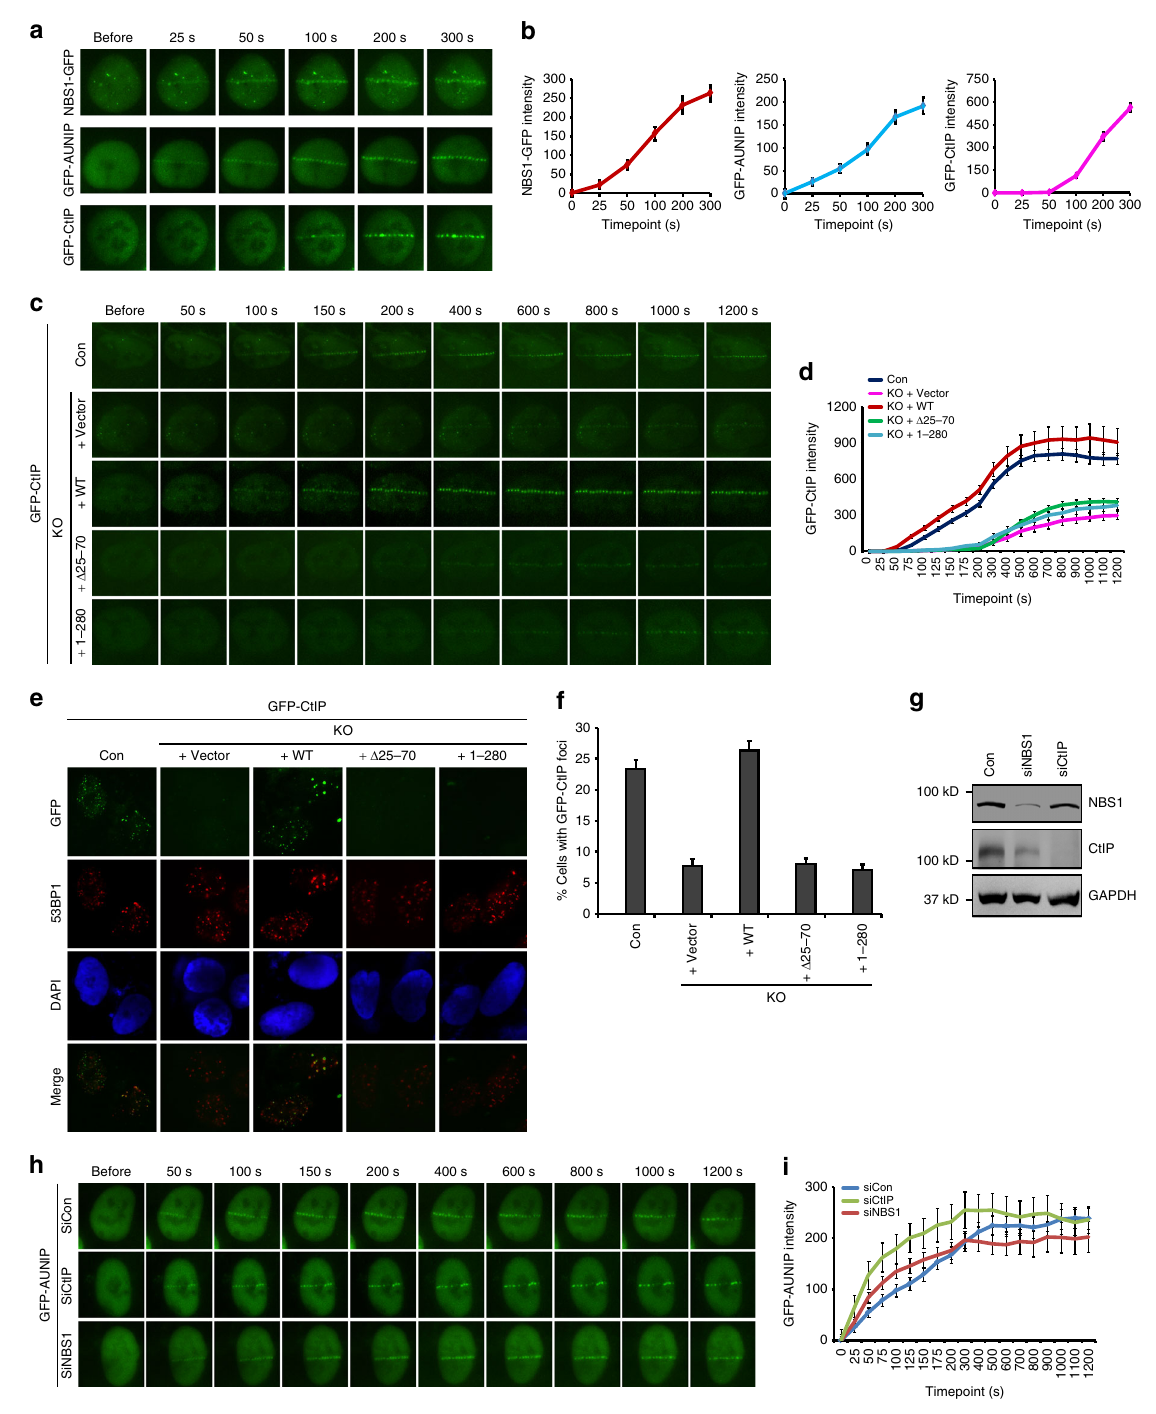
Fig. 5 AUNIP promotes CtIP recruitment to DNA damage sites. a , b Kinetic studies of accumulation of GFP-tagged AUNIP, NBS1, or CtIP at laser-induced DNA damage sites. U2OS cells stably expressing GFP-AUNIP, NBS1-GFP, or GFP-CtIP were laser micro-irradiated and were monitored by live cell imaging ( a ). The intensity of fl uorescence at the site of damage was quanti fi ed b . Data were derived from analysis of at least 20 cells in each experiment and are presented as mean ± SEM. c , d Knockout of AUNIP impairs CtIP recruitment to laser-induced DNA damage sites. AUNIP-de fi cient U2OS cells stably expressing empty vector (Vector), wild-type AUNIP, the Δ 25 – 70 mutant, or the 1 – 280 mutant were infected with a lentiviral vector expressing GFP-tagged CtIP. After 48 h, cells were laser micro-irradiated and were monitored by live cell imaging ( c ). Data were derived from analysis of at least 20 cells in each experiment and are presented as mean ± SEM ( d ). e , f Knockout of AUNIP impairs CPT-induced CtIP foci formation. Cells infected with a lentiviral vector encoding GFP-tagged CtIP were treated with 1 μ M CPT for 1 h and were processed for immuno fl uorescence studies. Representative CtIP foci are shown in e . Data represent mean ± SEM from three independent experiments ( f ). g – i Neither NBS1 nor CtIP is required for AUNIP damage recruitment. Cells transfected with indicated siRNAs were laser micro-irradiated and were monitored by live cell imaging ( h ). Data were derived from analysis of at least 20 cells in each experiment and are presented as mean ± SEM ( i ). Knockdown ef fi ciency of NBS1/CtIP was con fi rmed by western blotting ( g